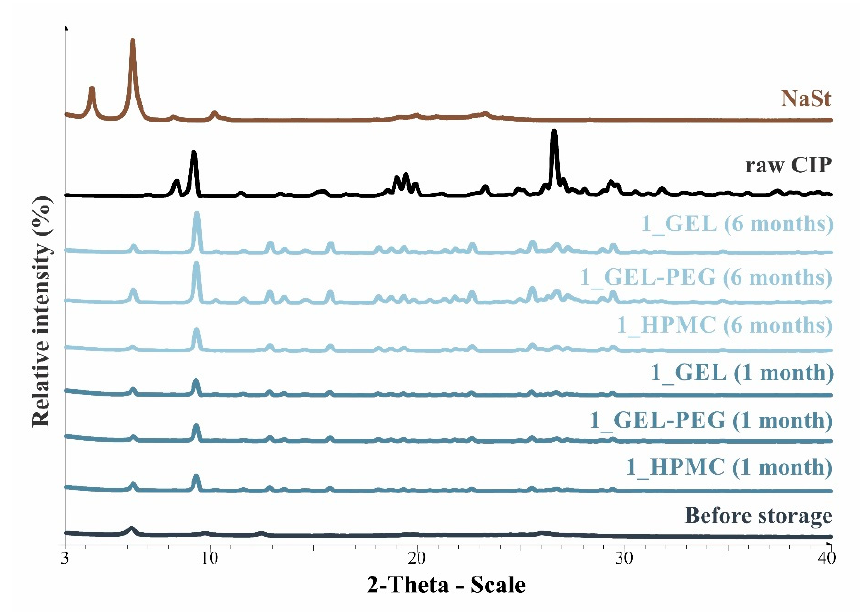
Figure 2. XRPD patterns of raw CIP and formulation 1 during the stability